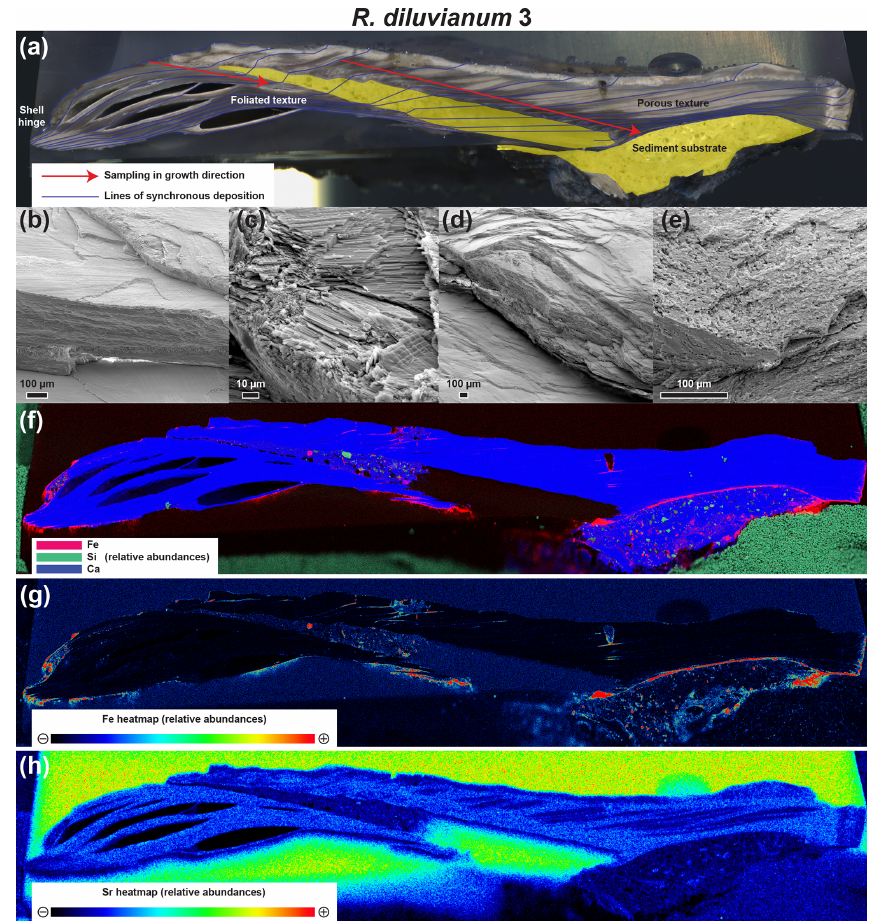
Figure 3. Overview image showing a high-resolution color scan of the cross section through R. diluvianum (a) on which the different shell textures as well as the directions of high-resolution analyses (in growth direction) are indicated. Thin blue lines denote parts of the shell that were deposited at the same time (growth increments). Areas marked in yellow represent sediment infilling below and within the valves. (b) and (c) show SEM images of the well-preserved foliated calcite in the shell. More porous structures in the shell (vesicular calcite) are depicted in SEM images shown in (d) and (e) . Below are three XRF elemental maps of the same cross section: an RGB-colored map displaying the relative abundances of Fe, Si and Ca (f) ; a heatmap of Fe concentrations ( g ; see scale bar below map) and a heatmap of Sr concentrations ( h ; see scale bar below map). XRF mapping only yields relative (semi-quantitative) abundance of